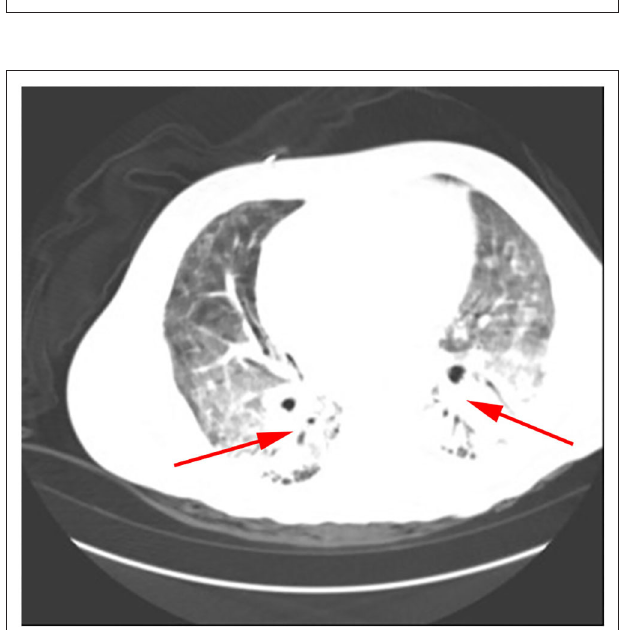
FIGURE 4 | P. jirovecii appearances on Chest CT scan in patient 3 as a large number of meshwork shadows and multiple small nodules in both